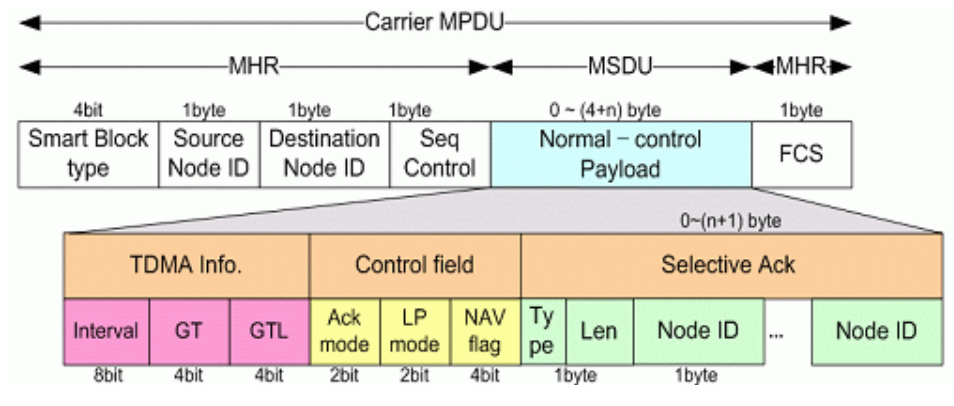
Figure 9. Beacon Frame with